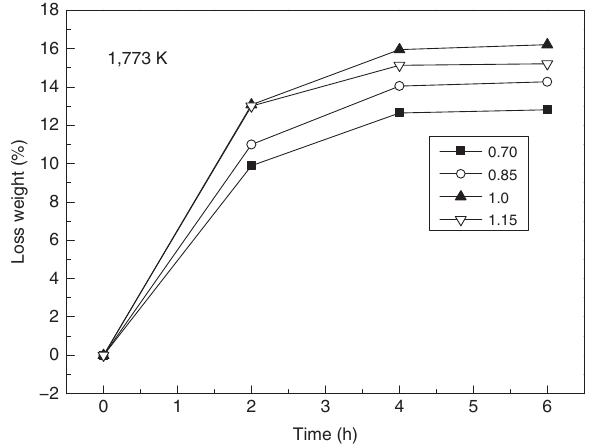
Figure 6: The percentage of total mass loss with carbon ratio of 0.7 at different temperatures.